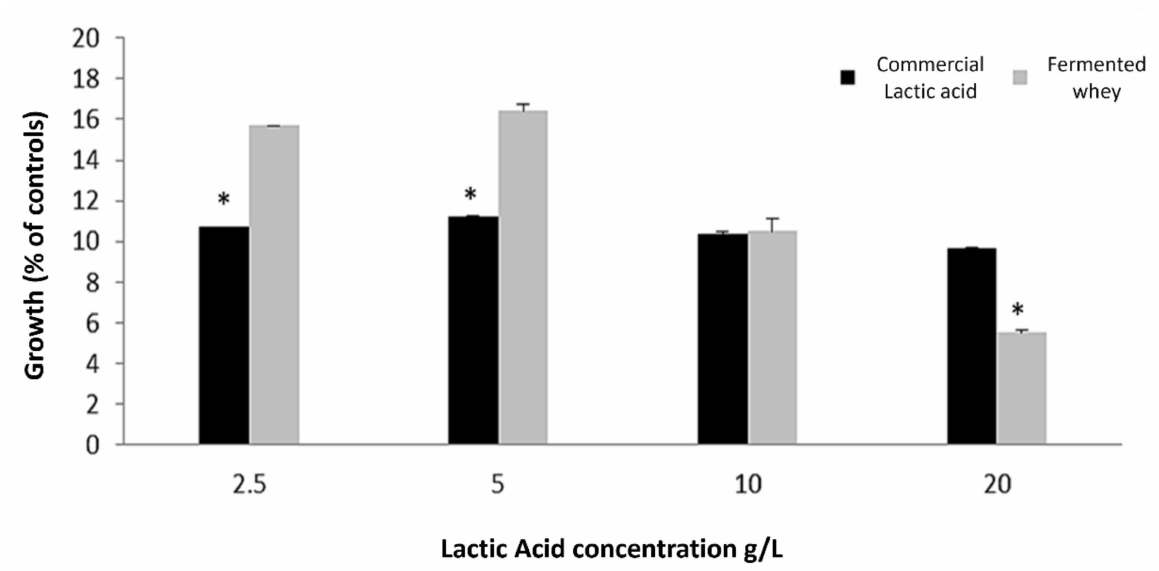
Figure 2. L. monocytogenes growth when exposed to different serial dilutions of the 6-day-fermented whey and commercial lactic acid in concentrations equal to those present in the fermented whey at each dilution. Bacterial growth is expressed as % of controls ± SD. * p <